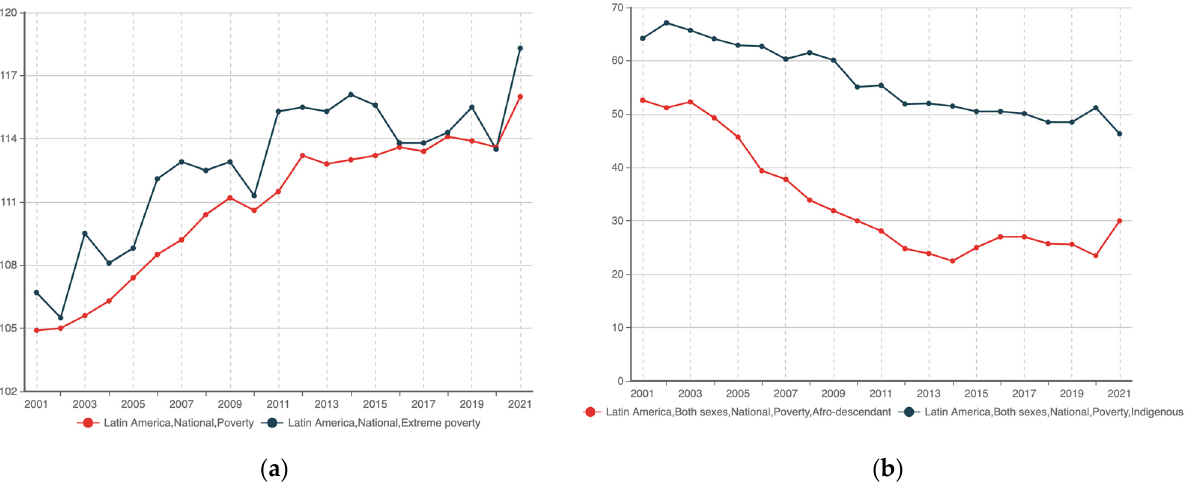
Figure 2. ( a ) Femininity index of extreme poverty and poverty in Latin America, 2001–2021. Source: CEPAL 2022. ( b ) Population living in extreme poverty and poverty by ethnicity and sex, 2001–2021. Source: CEPAL 2022.